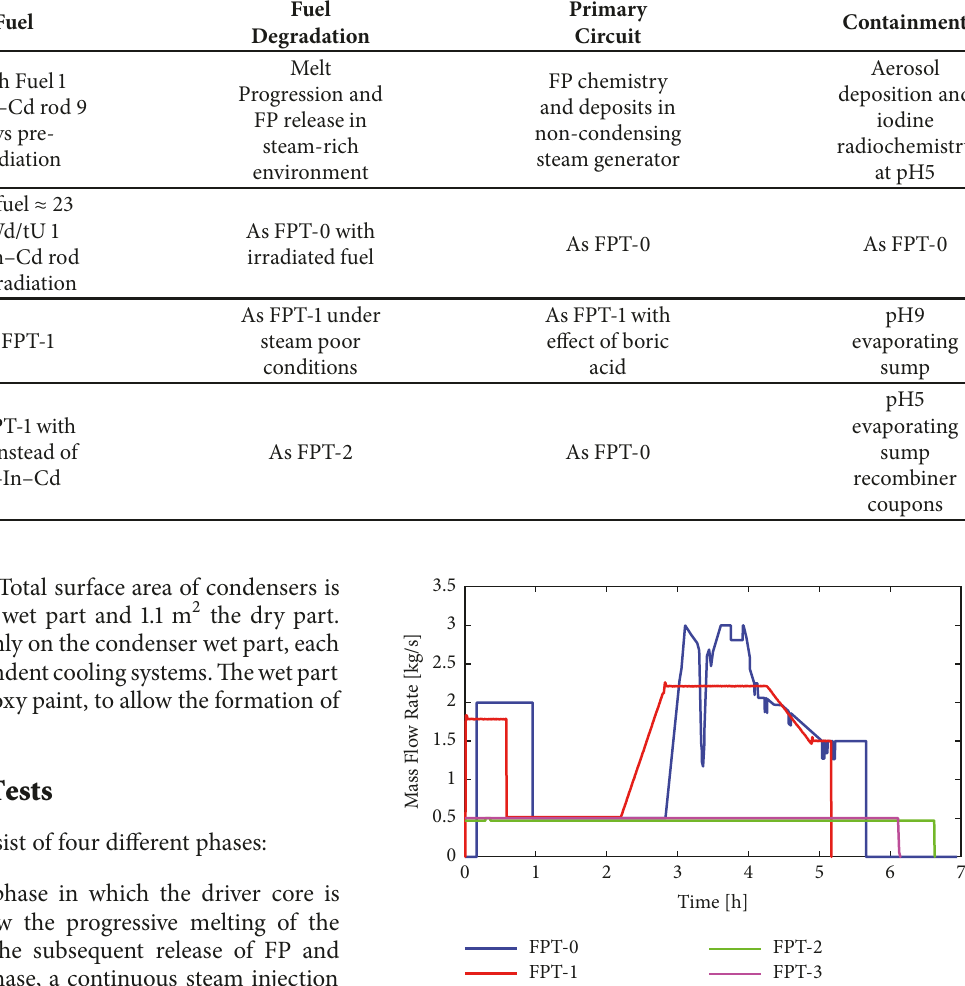
Figure 2: Steam flowing into the CV during the Ph´ebus FPT